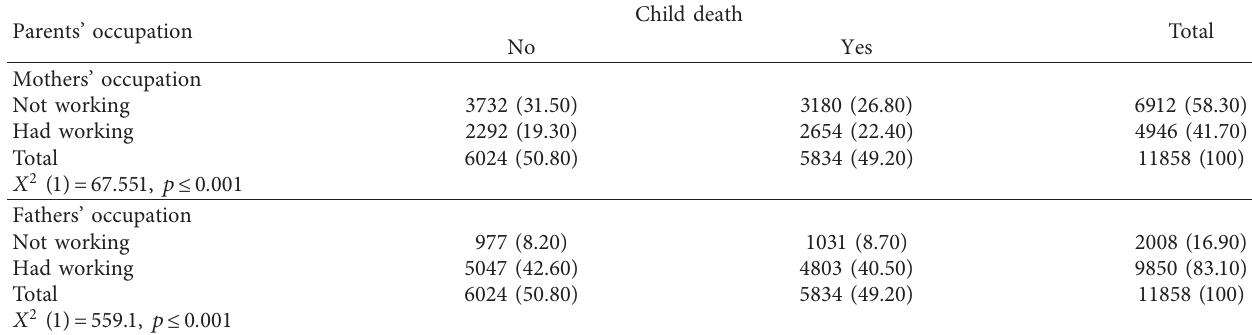
Table 6: Parents’ occupation on child mortality.